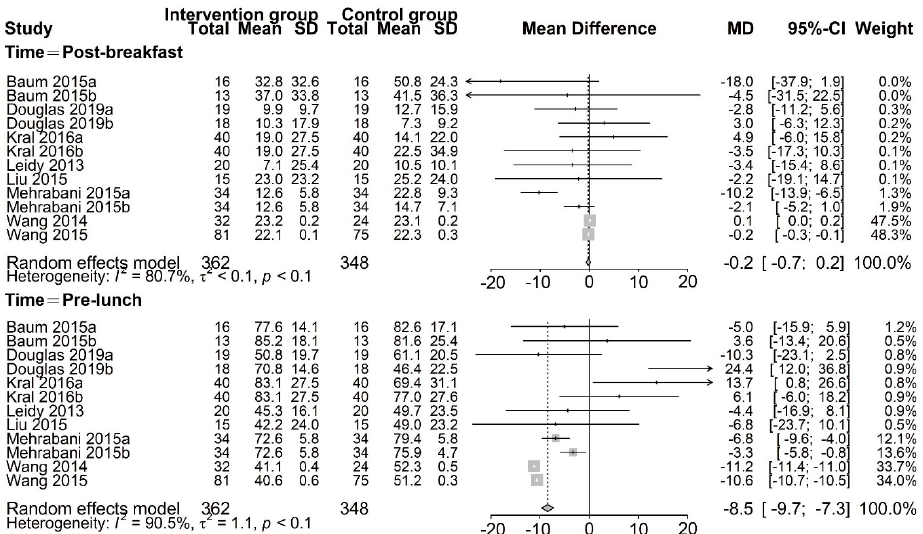
Figure 6. Random–effects meta–analysis of relationships between protein–rich breakfast and hunger (mm). Data for Baum 2015a [13] are based on non–overweight participants, whereas data for Baum 2015b [13] are based on overweight participants. Bellissimo 2020a [20], Bellissimo 2020b [20], and Bellissimo 2020c [20] are based on different subsets of subjects